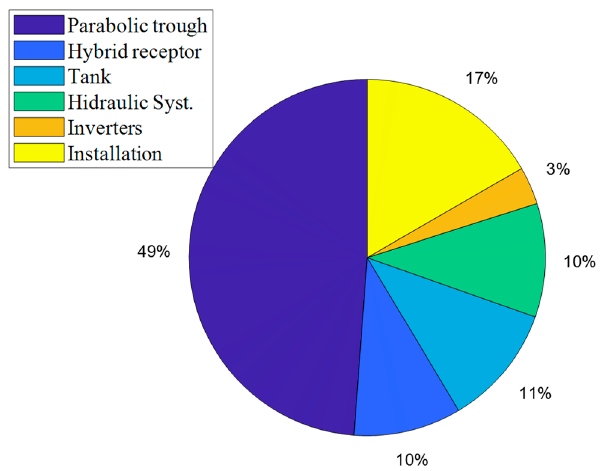
Figure 6. Breakdown of the investment costs for the hybrid solar plant (Source: Author’s own calculation).